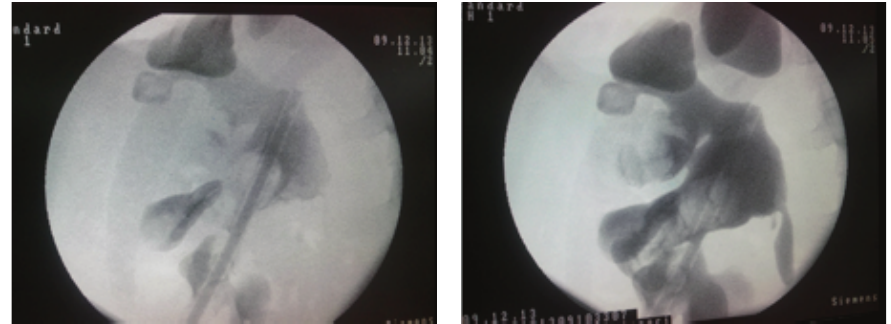
Figure 3: Postoperative second day nephrostography showed passage through ureter and no